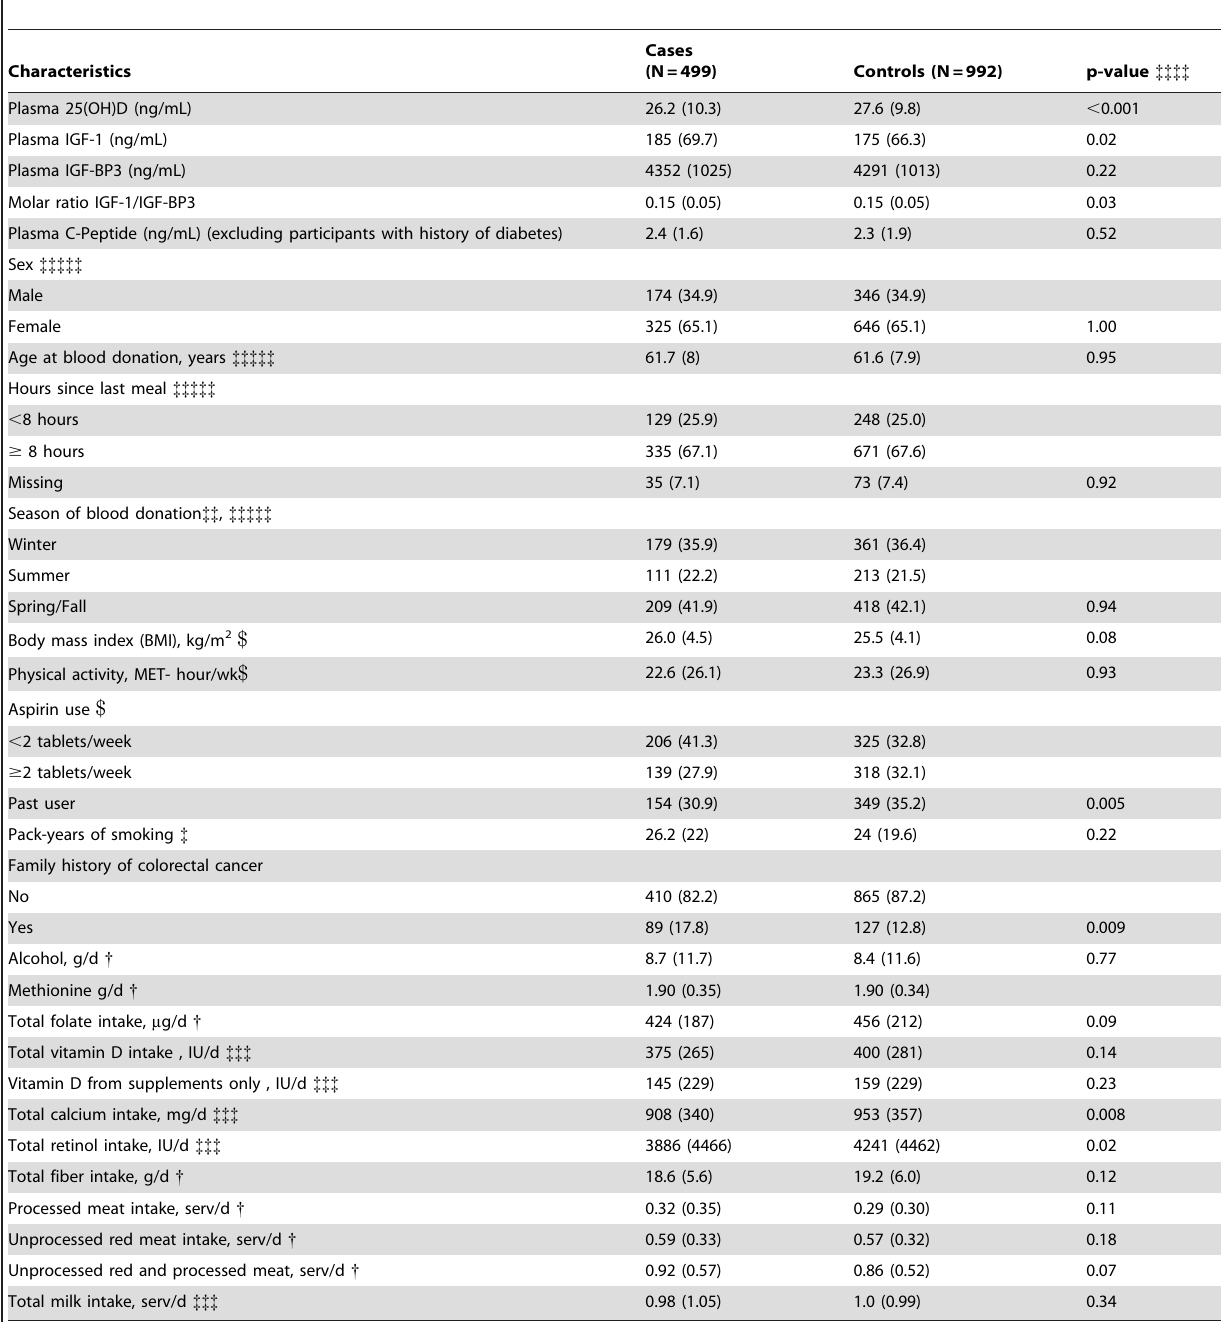
Table 1. Mean plasma analyte levels and baseline characteristics for cases and controls Health Professionals Follow-up Study (HPFS), 1994–2002 and Nurses’ Health Study (NHS), 1990–2008 (combined).